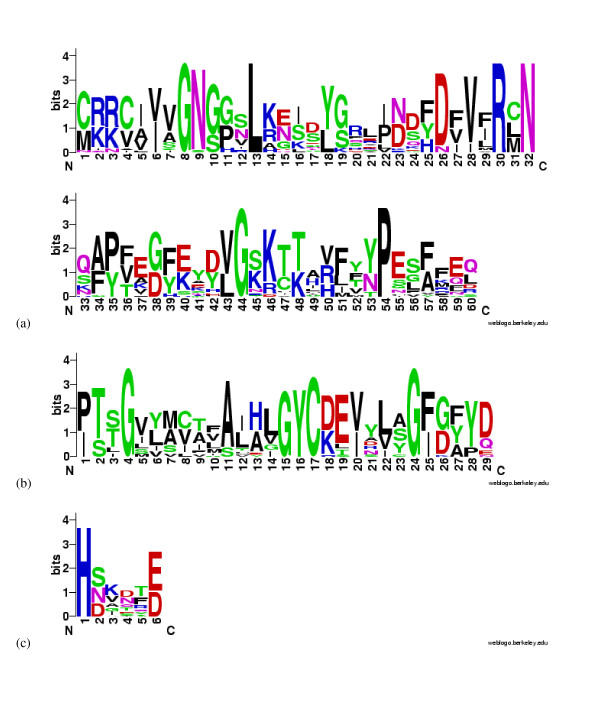
Sequence logos of (a) extended L-motif (b) S-motif (c) VS-motif. The conserved regions for generating the logos were extracted from the multiple sequence alignment of 23 experimentally characterized only α2,3-SiaTs from GT29 families and GT42 families (see Additional file 11). The multiple sequence alignment was generated using the FUGUE server. The colors used for the logos are as follows: blue, Lys, Arg and His; green, Cys, Ser, Gly, Thr and Tyr; red, Asp and Glu; pink, Asn and Gln; black, Ala, Val, Leu, Phe, Ile, Met, Pro and Trp.